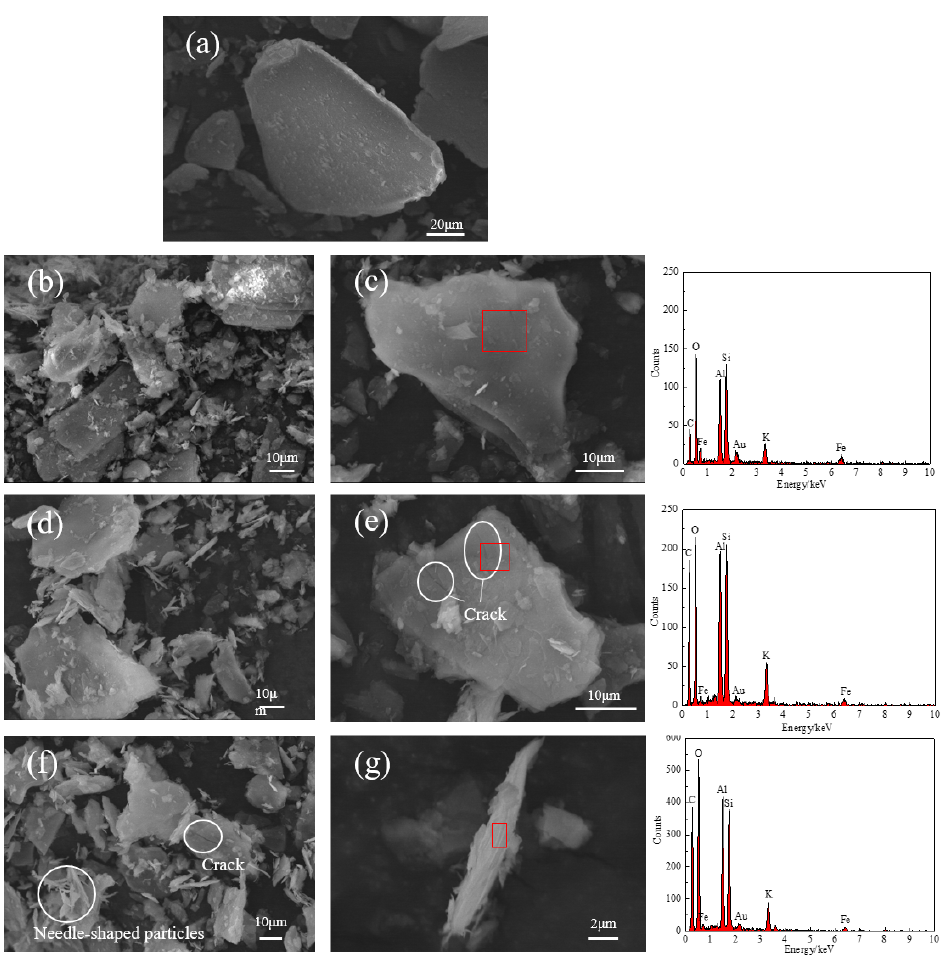
Figure 7. Surface morphologies of muscovite products with different dosages of SHMP (the red frame area is the EDS detection area). ( a ) Raw material, ( b , c ) no SHMP, ( d , e ) 0.2% SHMP, ( f , g ) 0.8% SHMP.